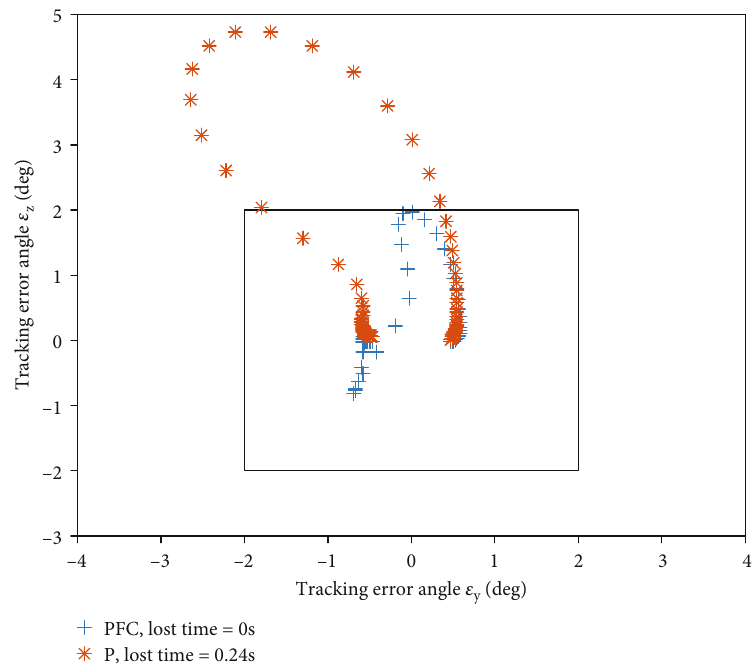
Figure 9: Tracking errors of PFC and PI (1 deg,